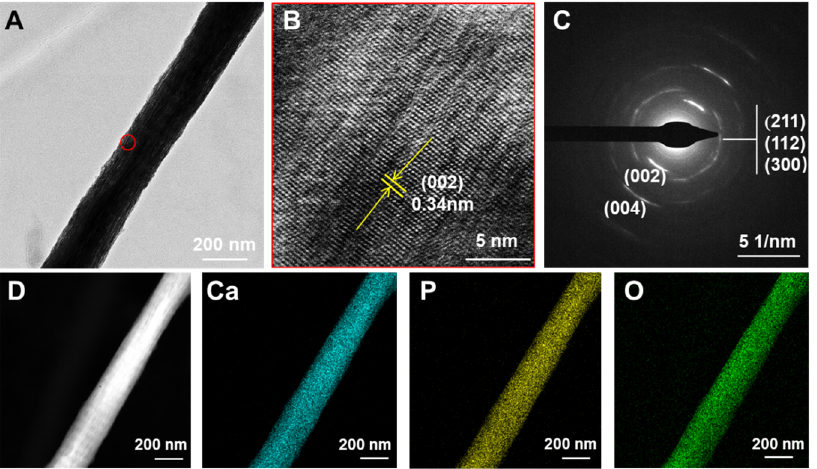
Figure 2. HAP nanocrystal orientation and composition of a single collagen fibril with intrafibrillar HAP nanocrystals: ( A ) TEM of the fibril. ( B ) HRTEM of the red area in ( A ). ( C ) SAED of the fibril, and ( D ) EDS mapping of the fi bril.